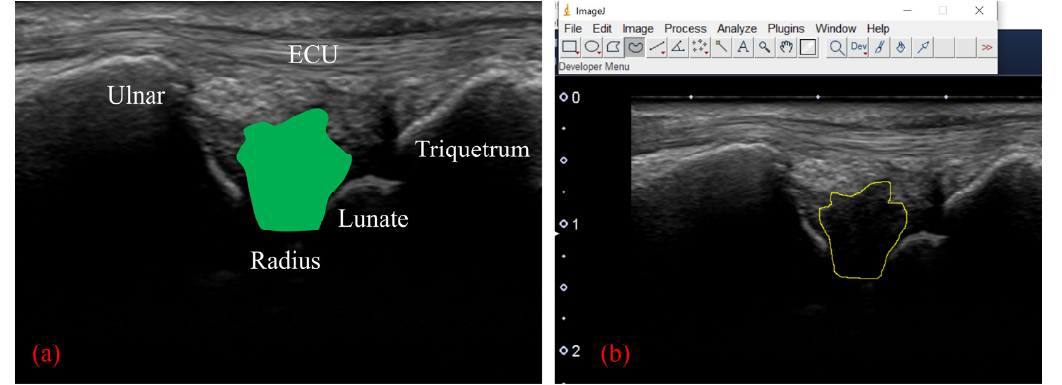
Figure 4. ( a ) We calculated the area of the articular disc up to the depth of the lunate cartilage (green area). ( b ) Calculation of the area using ImageJ software. The low-echo articular disc was manually plotted and measured with a measurement tool of Image J.